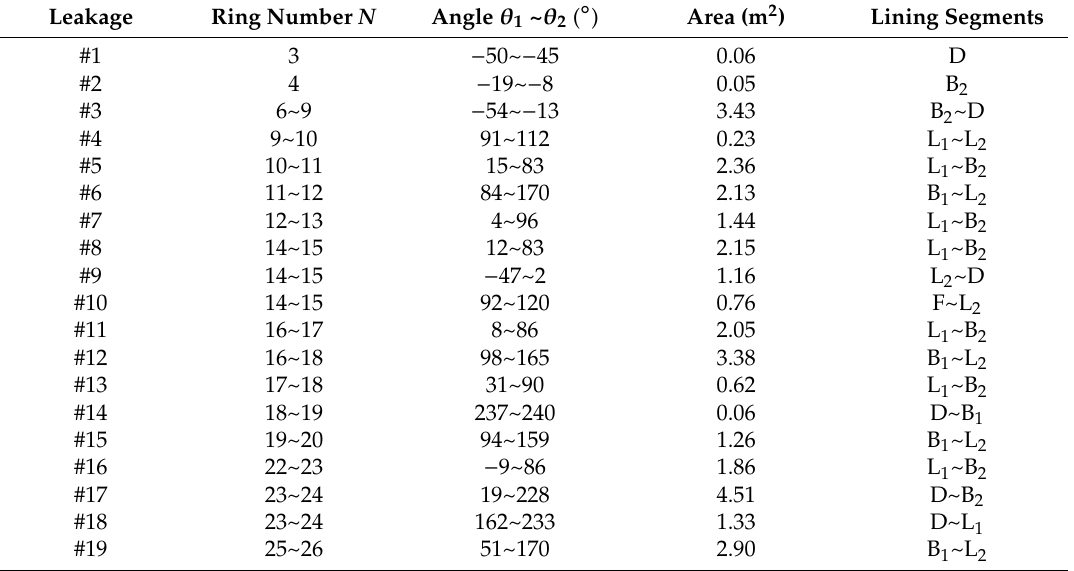
Table 1. The evaluation result of the water leakages in a 50 m shield tunnel